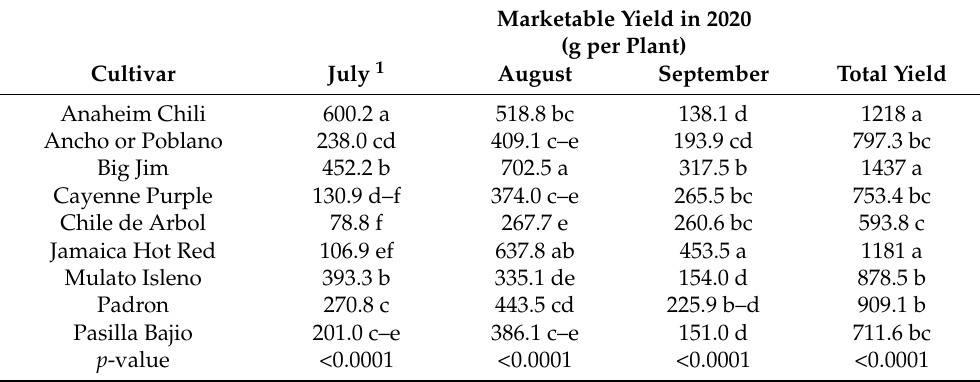
Table 2. Marketable yield of nine heirloom chile pepper cultivars grown in a container production system in Starkville, Mississippi, during the 2020 growing season.